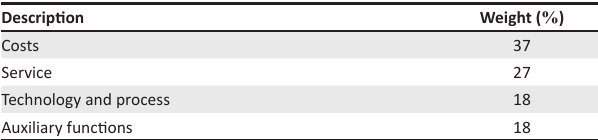
TABLE 1: Area weightings.